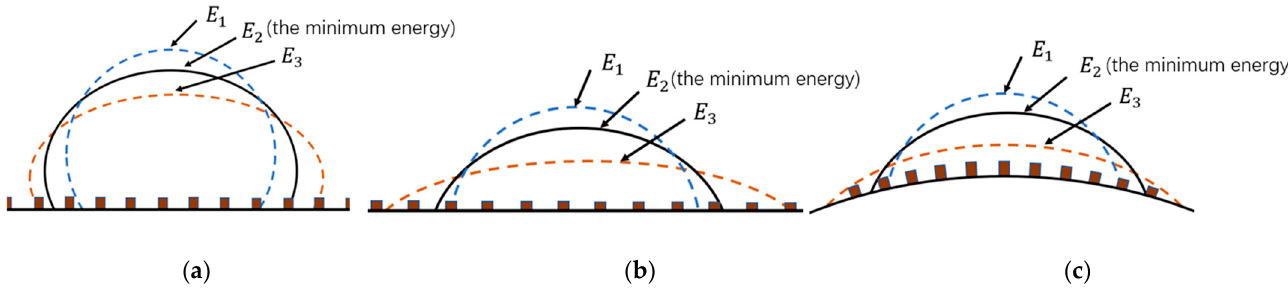
Figure 3. E2 is the minimum total energy in all possible total energies; thus, state 2 is the real state. ( a ) An axisymmetric heavy droplet on a microstructured superhydrophobic plane. ( b ) An axisymmetric heavy droplet on a microstructured superhydrophilic plane. ( c ) An axisymmetric heavy droplet on a microstructured superhydrophilic external spherical surface.